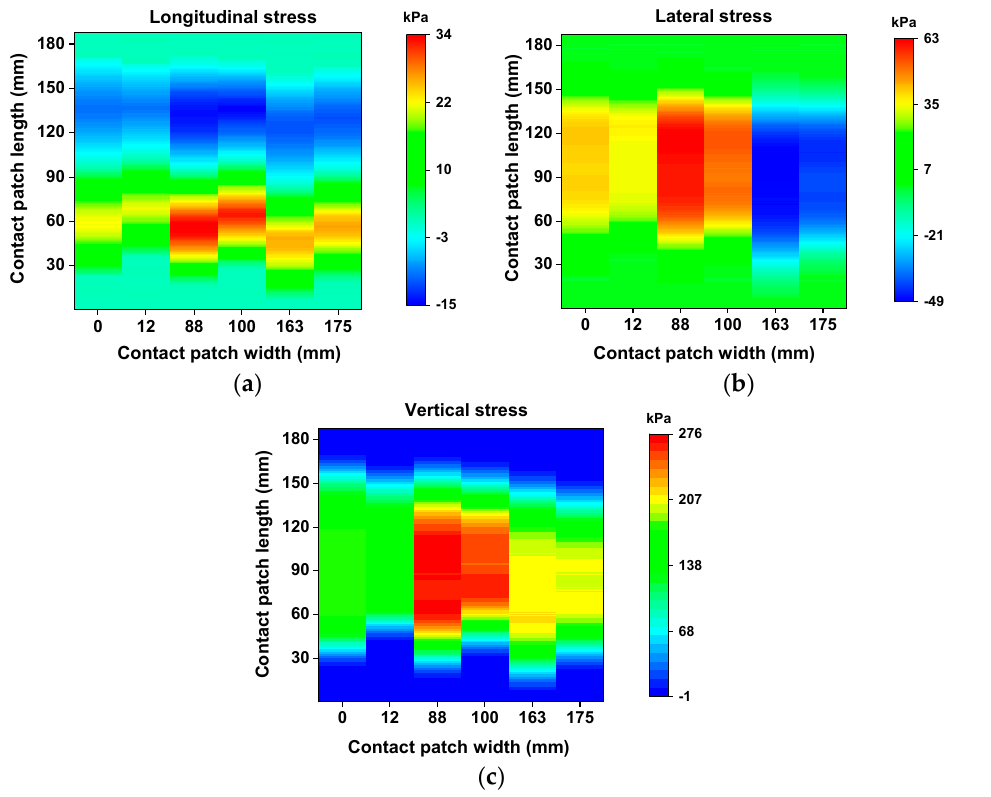
Figure 10. ( a ) Longitudinal (X) stress distribution; ( b ) lateral (Y) stress distribution; ( c ) vertical (Z) stress distribution.